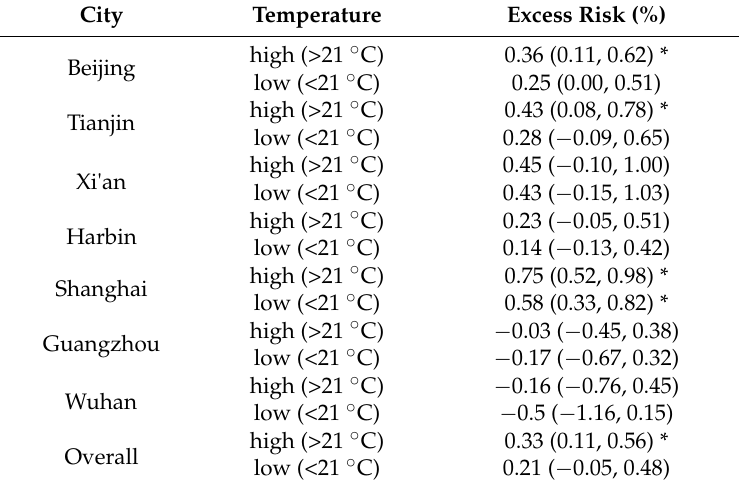
Table 3. Acute effects of ambient temperature on non-accidental mortality in different levels of seven large cities in China.